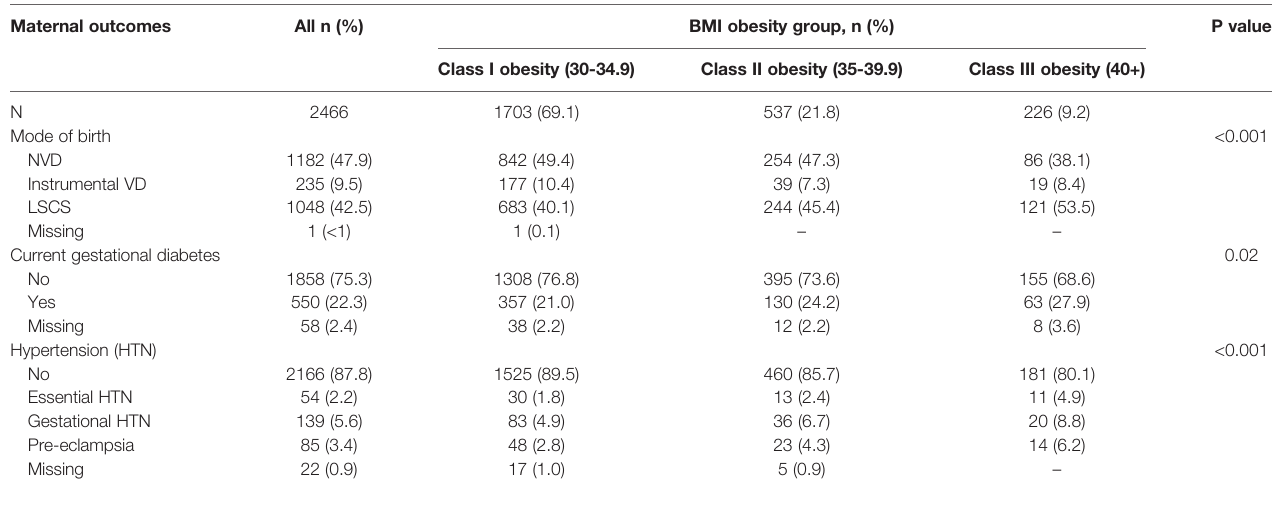
TABLE 2 | Maternal outcomes by obesity